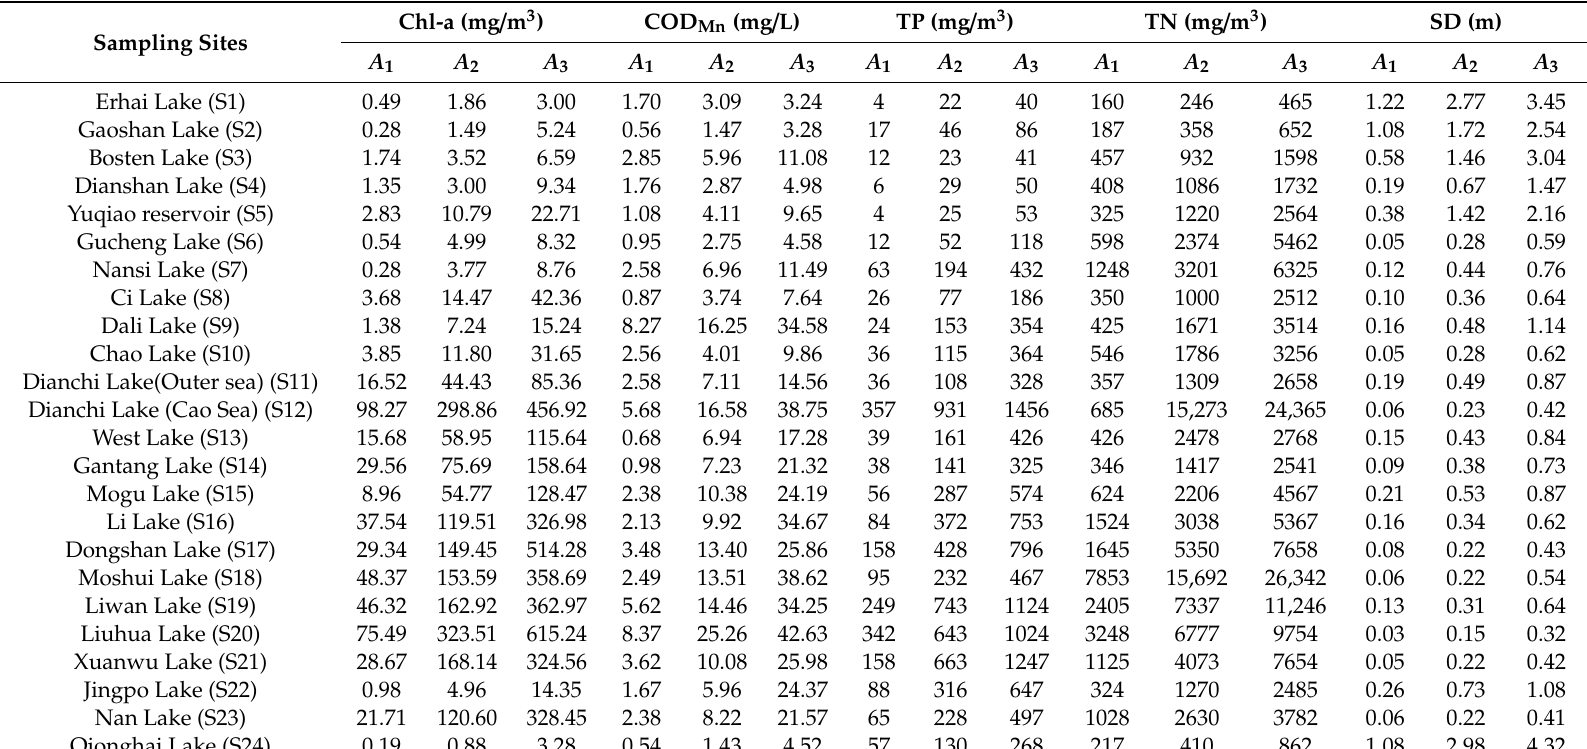
Table 5. Lower, expected and upper value of TFN approach for Lake (termed as A 1 , A 2 , and A 3 , respectively). Sampling